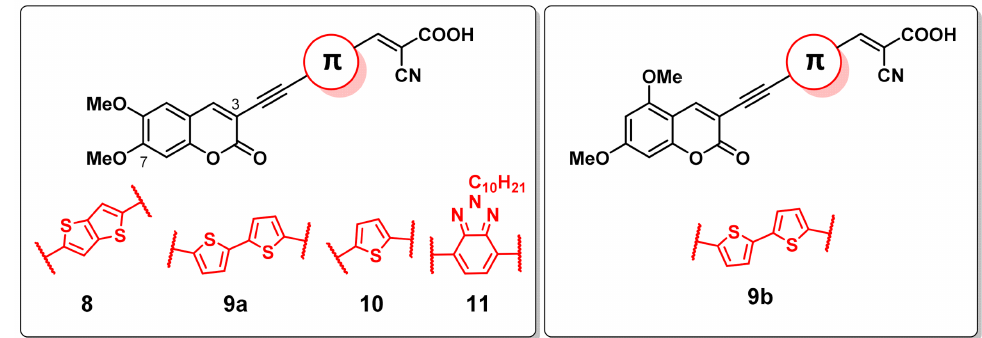
Figure 1. Structure of target dyes prepared and characterized in this